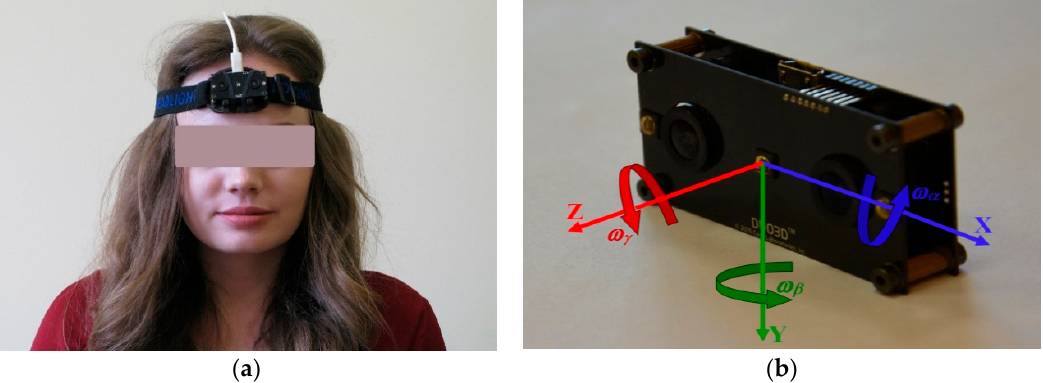
Figure 1. ( a ) Placement of the inertial measurement unit on the user’s head; ( b ) DUO MLX Stereo System equipped with inertial sensors with marked coordinate axes Ox , Oy , and Oz , and angular velocities ω α , ω β , and ω γ .